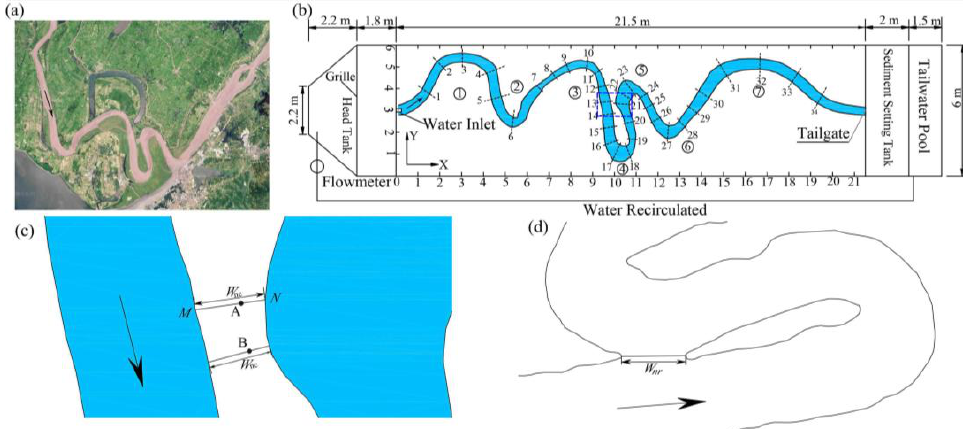
Figure 2. ( a ) The setup of the experiment was based on Qigongling Bend, a highly curved channel at the end of the lower Jingjiang River in the middle reaches of the Yangtze River, with a sinuosity of approximately 7. ( b ) Overall schematic diagram of the experimental system. ( c ) Enlarged schematic diagram of neck width W nc , which was the shortest channel width through the cutoff position; points A and B were possible cutoff locations, and the neck width was the length of section MN. ( d ) Schematic diagram of the new river width W nr formed after cutoff.